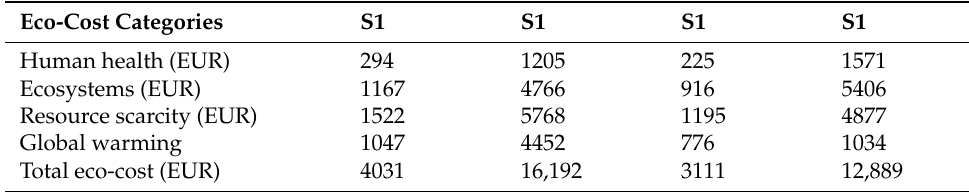
Table 9. Environment costs for lighting life cycle scenarios for year.